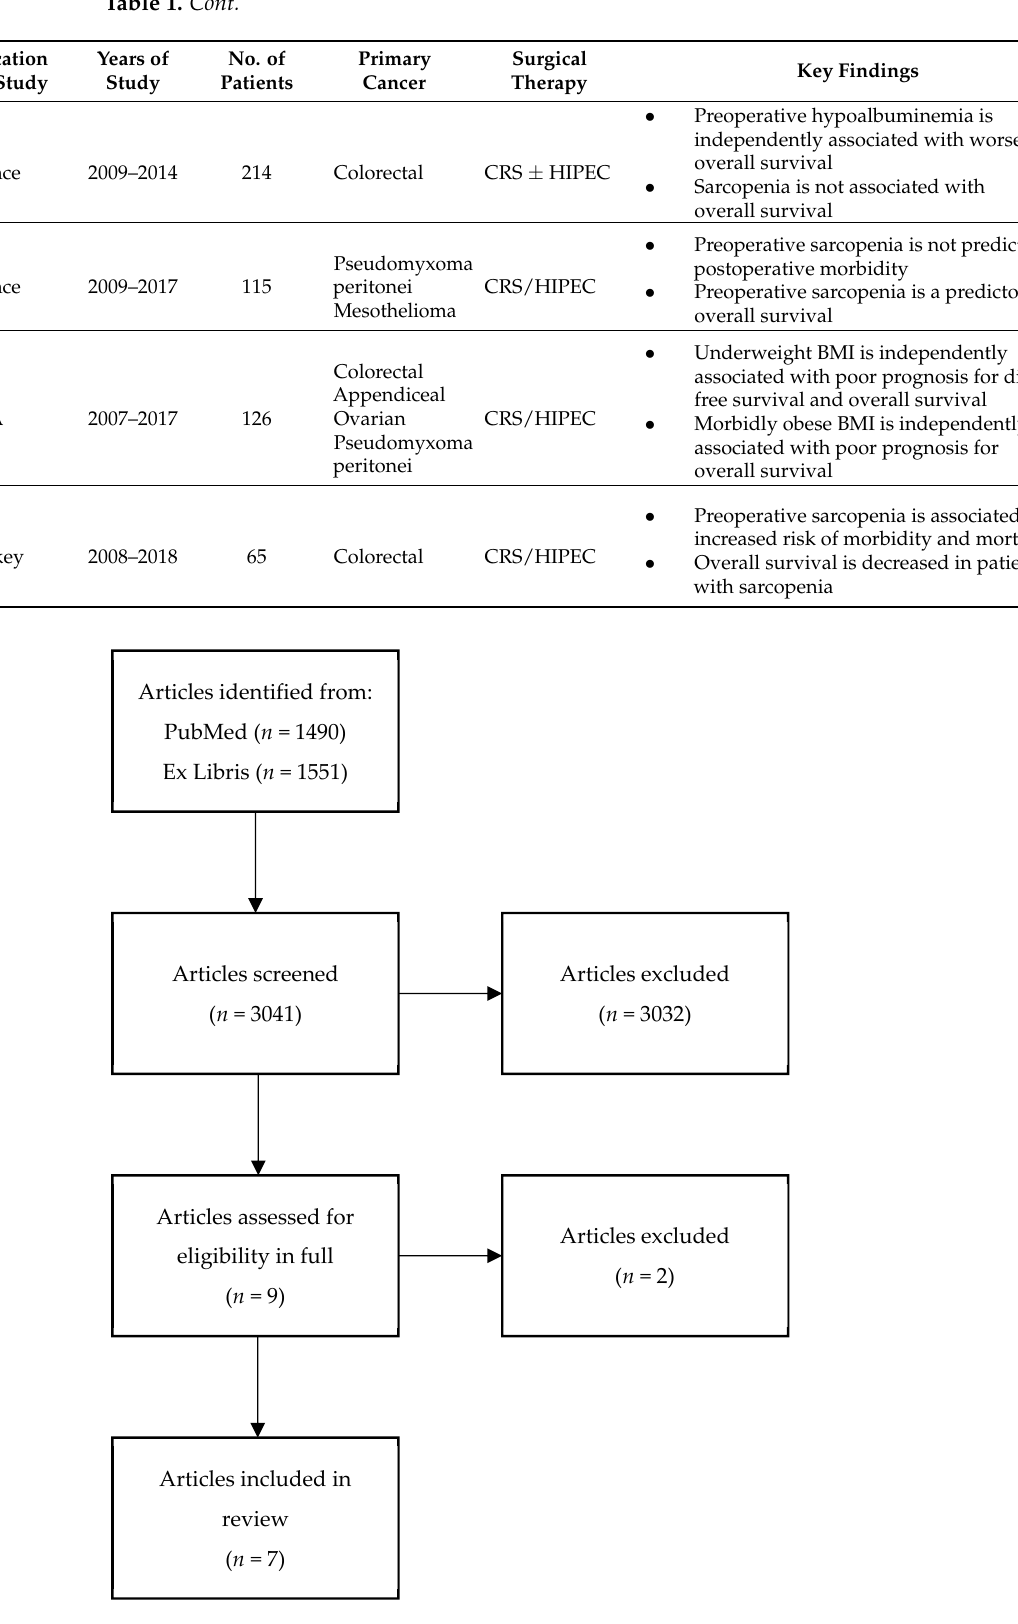
Figure 1. PRISMA diagram of the literature review. Table 1. Summary of key findings from studies included in review.